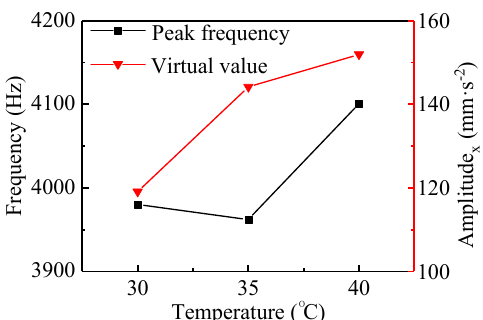
Figure 10. The peak frequency and RMS in the x-direction under different temperatures with the μ 1 friction coefficient.